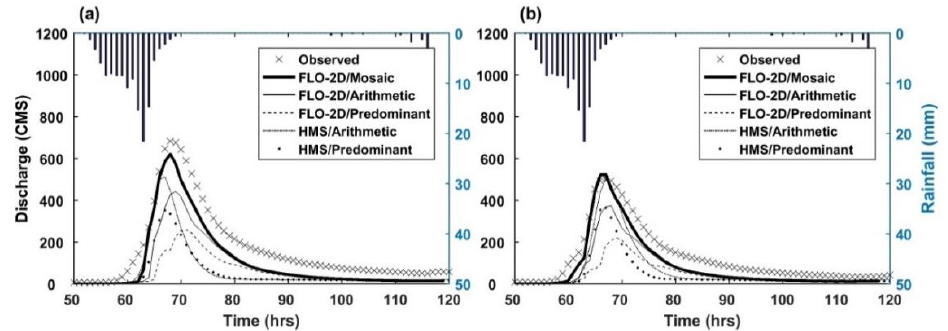
Figure 5. A time series of the model output simulated by both the FLO-2D and HEC-HMS against the observed, using the Green-Ampt: ( a ) Janghowon, ( b ) Cheonmi.